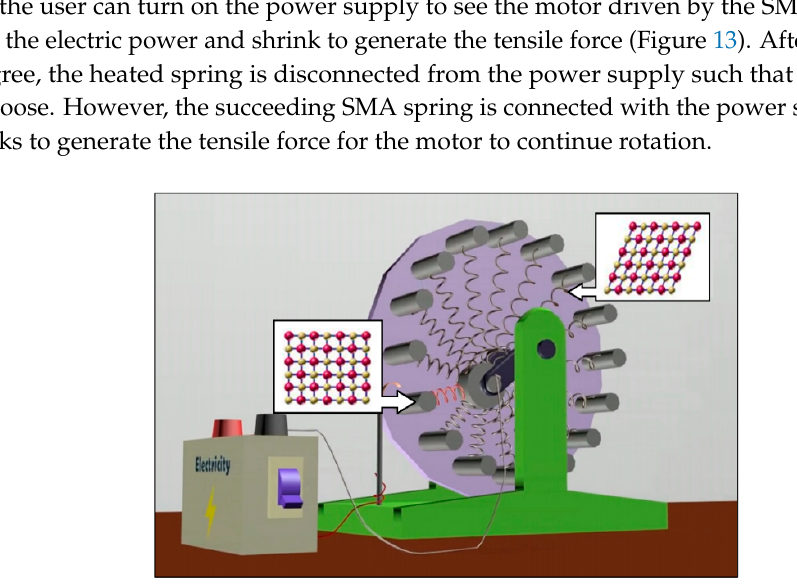
Figure 13. The heat-driven motor using SMA springs.